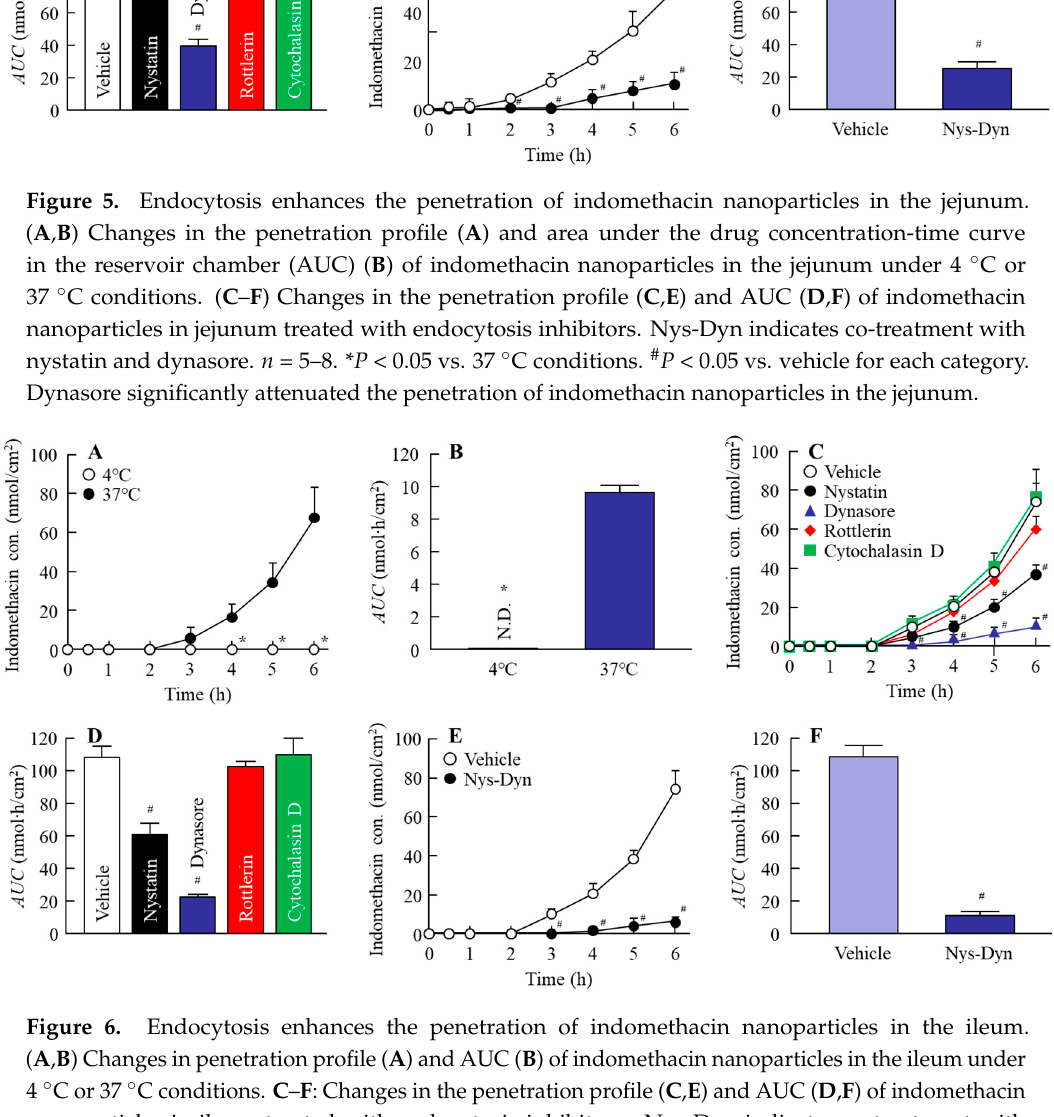
1.8 ± 0.3 The data in Figure 6A,C,E were calculated according to Equations 1–3. n = 5–8. * P <0.05, vs. Normal for each category. # P < 0.05, vs. Vehicle for each category. 3. Discussion Nanomedicines are recognized to have significantly improved cellular uptake and blood circulation time as compared to traditional formulations [20], and nanoparticle-based drug delivery systems have been introduced in many studies. Silica- and biodegradable-nanoparticles, dendrimers, polymer-drug conjugates, liposomes, quantum dots, polymeric micelles, etc. are classic examples of nanoparticulate materials currently being studied in laboratories, and some formulation technologies are already in use clinically [21]. We also designed a method to prepare solid nanoparticles using the